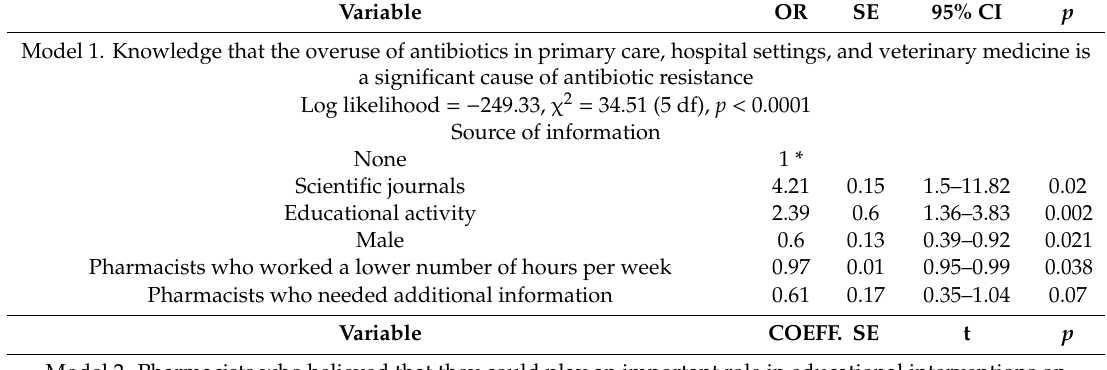
Table 2. Multivariate logistic and linear regression analysis to characterize factors associated with the di ff erent